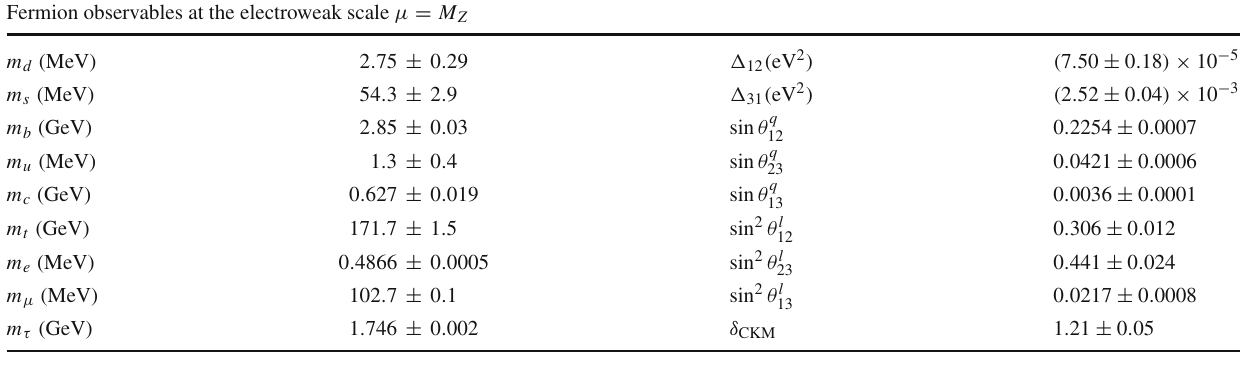
Table 1 SM input parameters at the electroweak scale, where quark and lepton masses and the quark mixing parameters are taken from Ref. [30], and neutrino mixing parameters from Ref. [31] for Normal Ordering (NO). As explained in the text, we use a 0 . 1% uncertainty Fermion observables at the electroweak scale μ = M Z